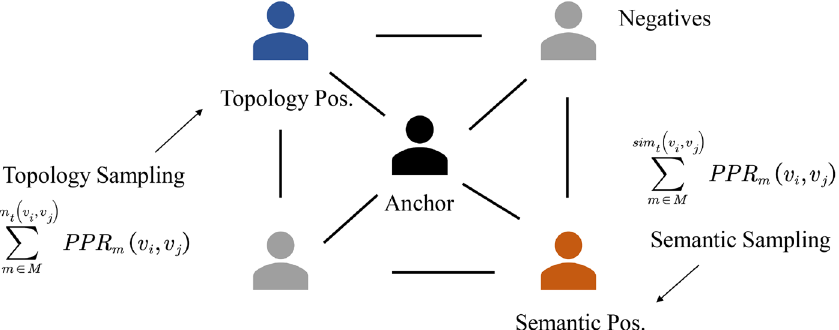
Figure 2. The positive sampling strategy. Personalized PageRank (PPR) is used to measure the topological similarity between nodes, and L2 distance is leveraged to compute the distance between nodes in semantic space to discover semantic